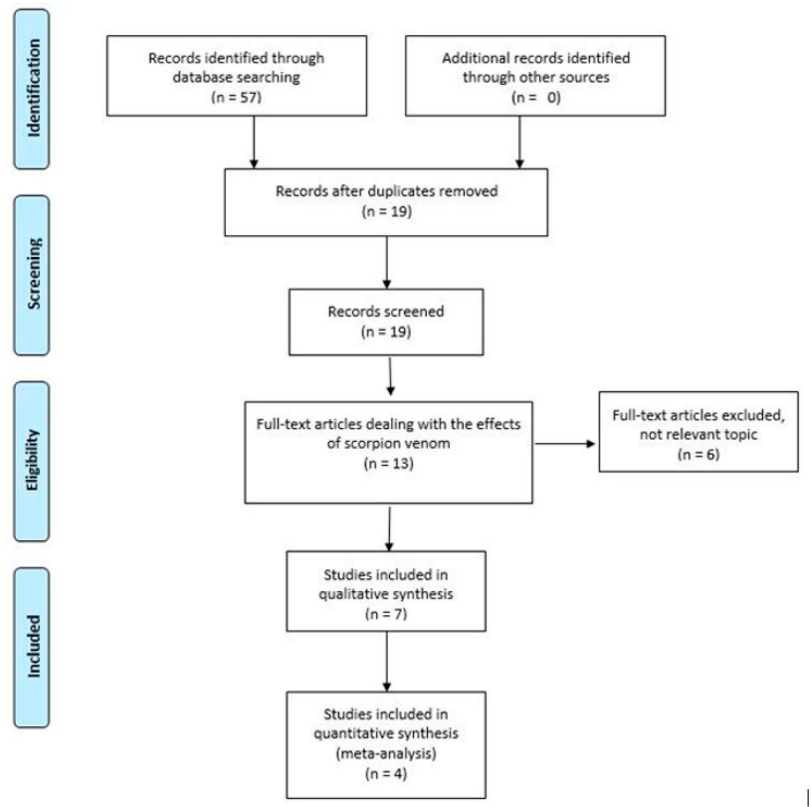
Figure 1. Flowchart of the different phases of the systematic review. Identification: 57; Screening: 19; Eligibility 13; Included 7; Meta-analysis 4.